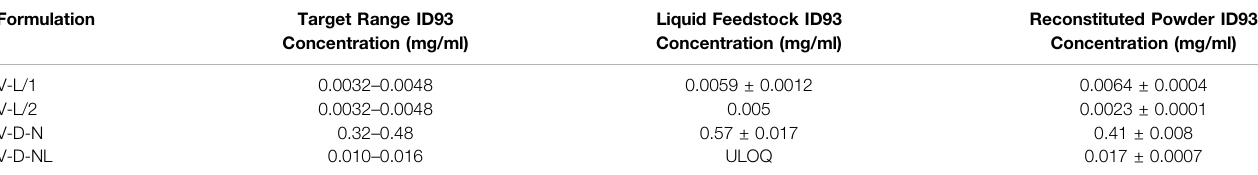
TABLE 8 | Comparison of the ID93 concentration of the liquid feedstock and the spray-dried powder as compared to the target concentration. Results are reported as the mean ± standard deviation. Nomenclature: V – Vaccine; L – Liquid; D – Dry powder; N – Nose; NL – Nose and Lung, ULOQ – Upper Limit of Quantitation (see Methods